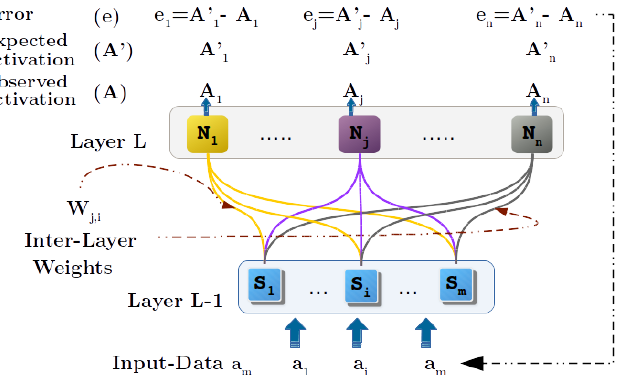
Figure 7. Single-window operation in geometric back-propagation operation. The figure also shows the error calculation and